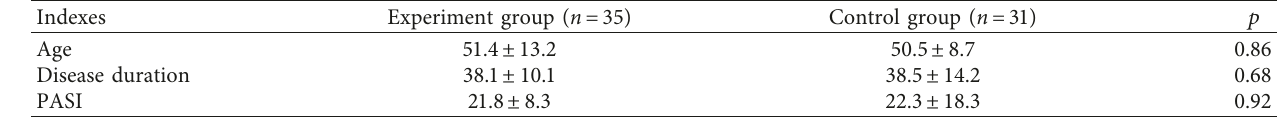
Table 2: Research group characteristics.